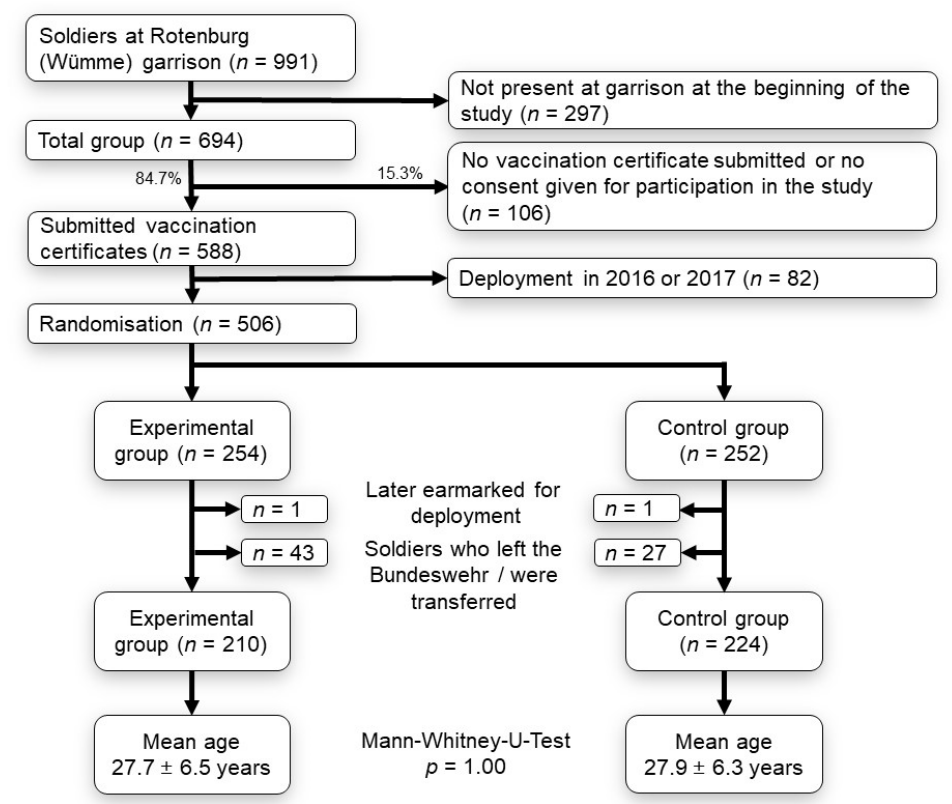
Figure 1. Flow chart on participant numbers ( n ) with exclusion criteria, subsequent randomisation and calculation of mean age.